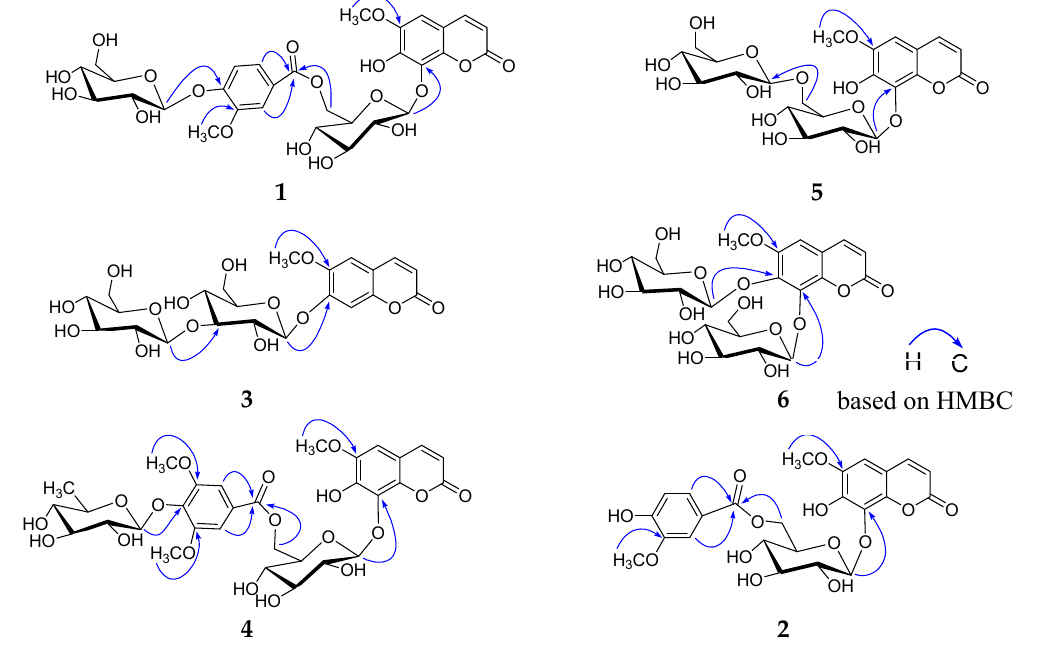
Figure 2. Key HMBC correlations of compounds 1 – 6 .